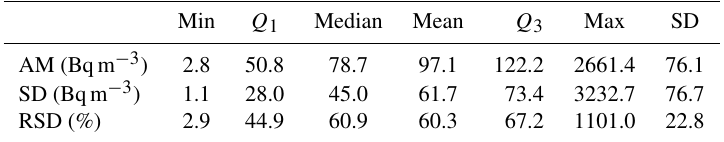
Table 7. Summary of indoor radon at the European scale.